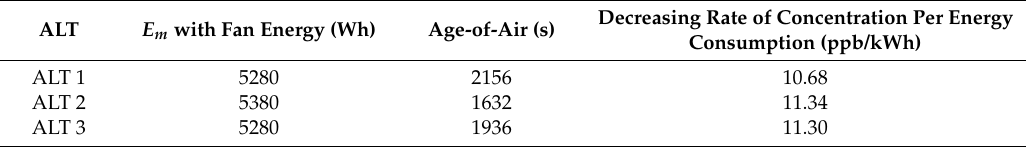
Table 9. Pollutant Concentration Reduction Effect per alternative